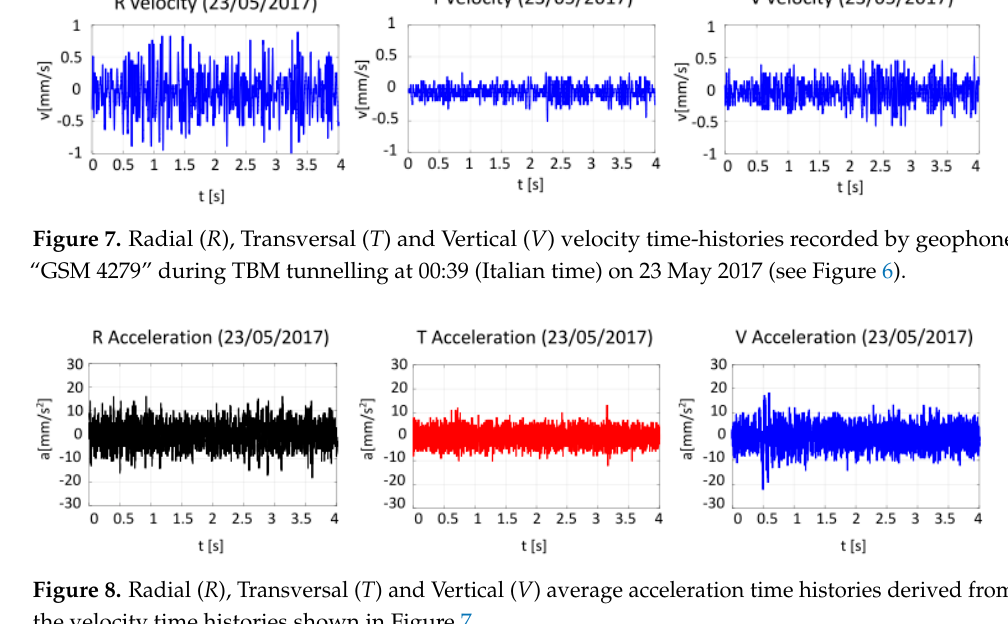
Figure 6. Layout of the geophones at the soil surface: ( a ) plan view; ( b ) zoom of the location of geophone n. 1 and TBM front; ( c ) detail of the used geophones.